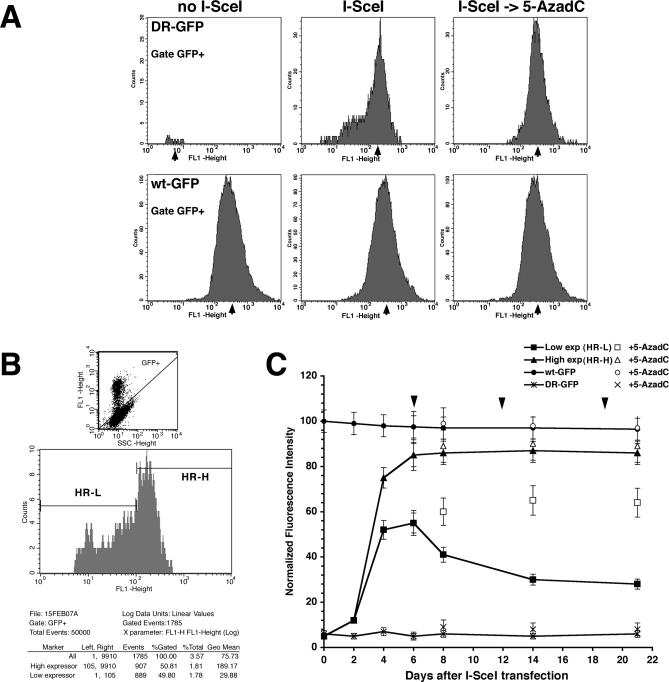
GFP Silencing in Recombinant ClonesHela cells carrying the DR-GFP or wild-type GFP plasmids were transfected with I-SceI and pSVβGal expression vectors, as described in Materials and Methods.(A) Shown is the fluorescence analysis of cell lines stably expressing wild-type GFP. Treatment with 5-AzadC was carried out as described in Figure 1. The cells were analyzed 7 d following 5-AzadC treatment. The GFP+ gate includes 95% of GFP-expressing cells. The mean fluorescence (arrow) and the % of GFP+ cells were: (1) DR-GFP (no-I-SceI) 7.4 and 0.4 %; (I-SceI) 203.56 and 4.7%; and (I-SceI+ 5-AzadC) 335.31 and 7.6%, respectively and (2) wild-type GFP (no-I-SceI) 357.51 and 95.4 %; (I-SceI) 361.12 and 96.2%; and (I-SceI+ 5-AzadC) 389.68 and 89.6%, respectively.(B) Hela cells carrying the DR-GFP plasmid were transfected with I-SceI and pSVβGal as indicated in Figure 1
. GFP+ cells were sorted by FACS and divided in two pools 4 d after transfection: HR-L and HR-H GFP expressors. The upper panel shows the gate used to select GFP+ cells. The lower panel shows only GFP+ cells and the gates used for sorting HR-L and HR-H.(C) GFP fluorescence in the mass culture was monitored by FACS before transfection and 2 d following transfection. Sorted cells were monitored at 4, 6, 8, 14, and 21 d after transfection. Parallel cultures at 6, 12, and 19 d posttransfection were treated for 24 h with 5-AzadC (arrows). 5-AzadC was washed away and GFP fluorescence was determined 24 h later. DR-GFP and wild-type GFP represent cell lines derived from DR-GFP pools transfected with pSVβGal plasmid or from a stable line expressing the wild-type GFP gene, respectively.